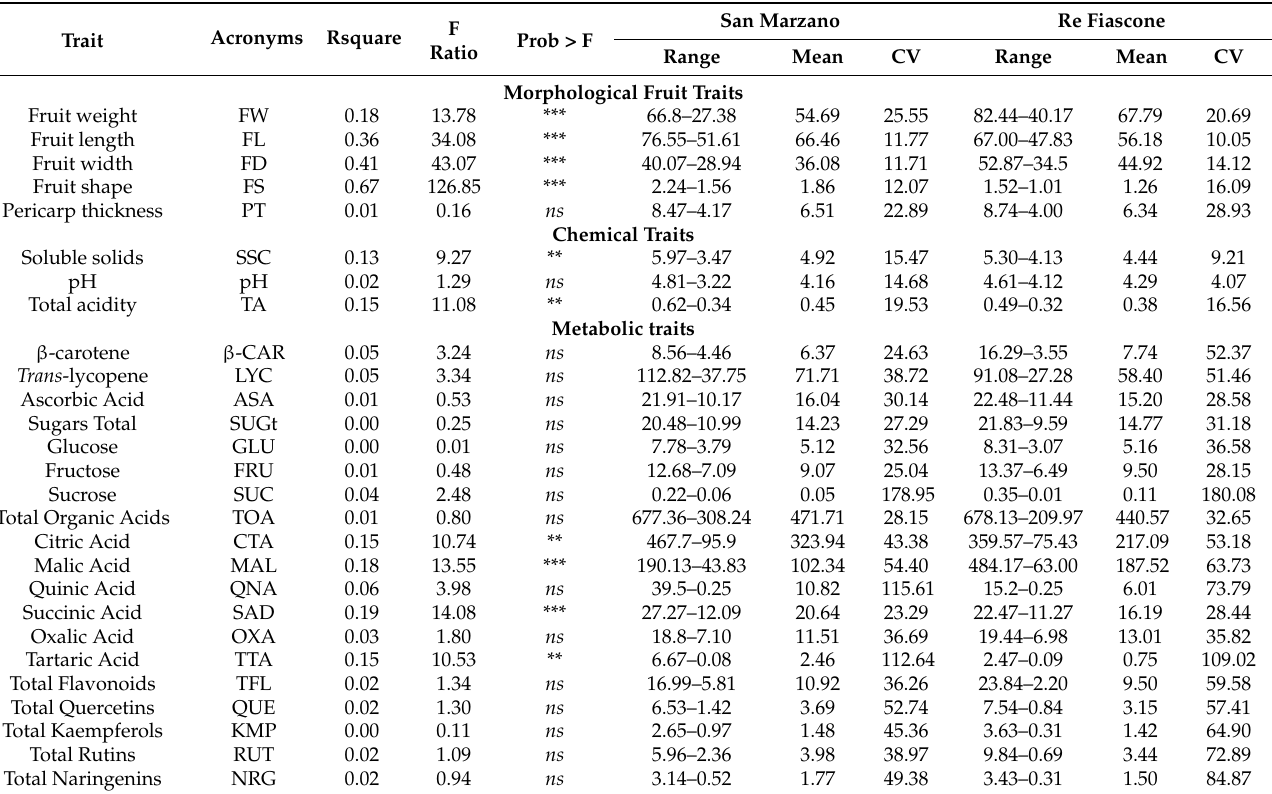
Table 3. MANOVA descriptive statistics, range, mean and coefficient of variation (CV) for traits analysed in the two tomato cultivar